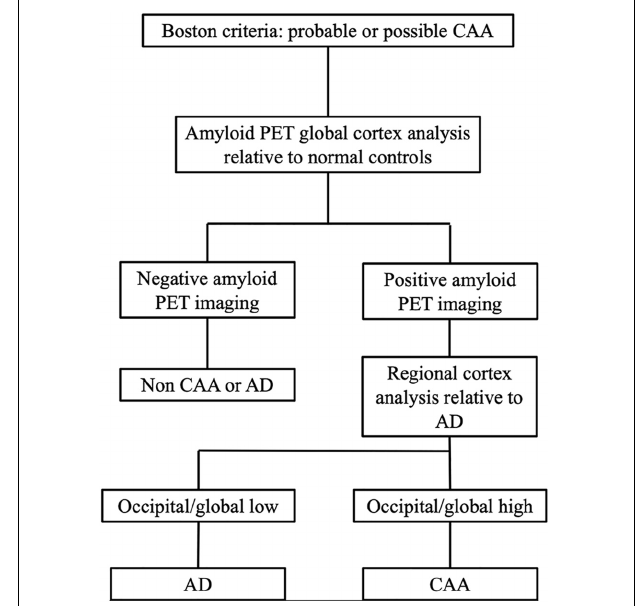
FIGURE 4 | Proposed workflow using PIB-PET/MRI in patients to diagnose CAA vs. AD. This approach is based on three successive steps: (i) MRI images were used to detect suspected CAA patients; (ii) Global PIB uptake analyses were used to rule out patients without CAA or AD; and (iii) if global PIB positivity was found, then the regional PIB uptake patterns were assessed to differentiate CAA and